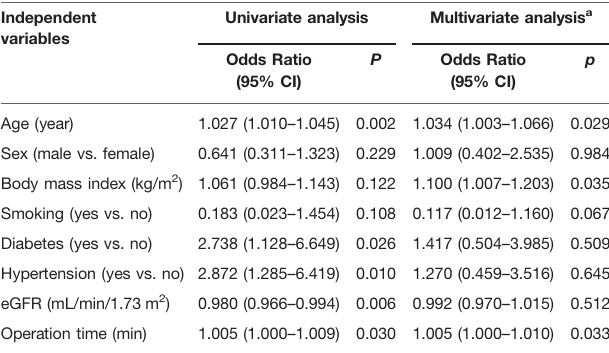
TABLE 3 | Associations between clinical factors and SpO 2 <95% after operation (dependent variable).